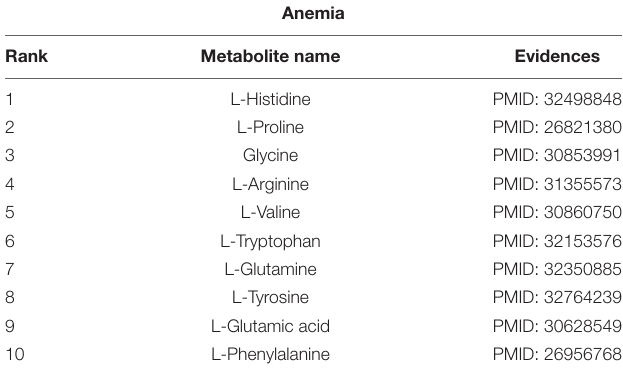
Table 1 | Candidate metabolites of